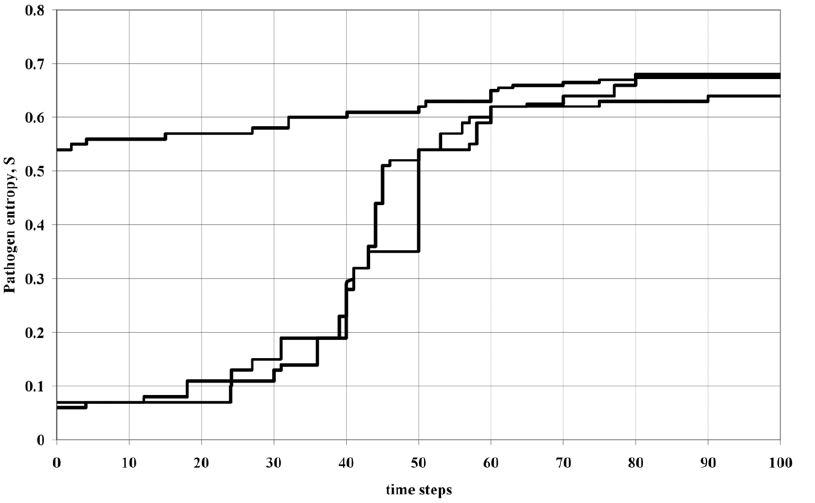
Figure 3. Simulations showing evolutionary entropy increasing over time for three realisations of the simulation (arbitrary units). This corresponds to the scenario of W v 0 , i.e. variants are competing against incumbents at equilibrium in the host population. Because D H D S w 0 , a plot of H versus time would yield the same pattern.